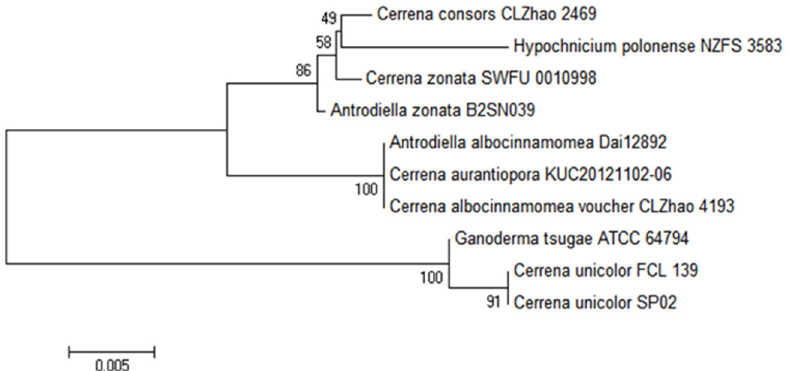
Figure 2. Neighbor ‐ joining phylogenetic tree of SP02 and related members based on ITS sequences blast. The phylogenetic tree was constructed using the MEGA 6.0 program. Bootstrap values (expressed as percentages of 1000 replications) >50% are indicated at the branch points. The scale bar indicates 0.005 nucleotide substitutions per site.